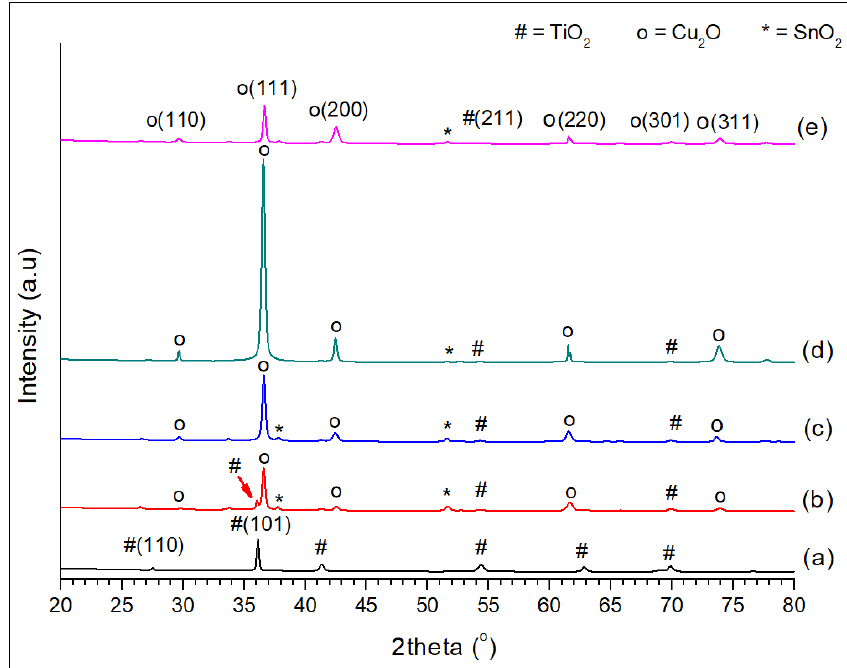
Figure 2. XRD diffraction patterns of samples (a) TiO 2 nanorods and Cu 2 O deposition for (b) 30, (c) 60, (d) 90, and (e) 120 minutes